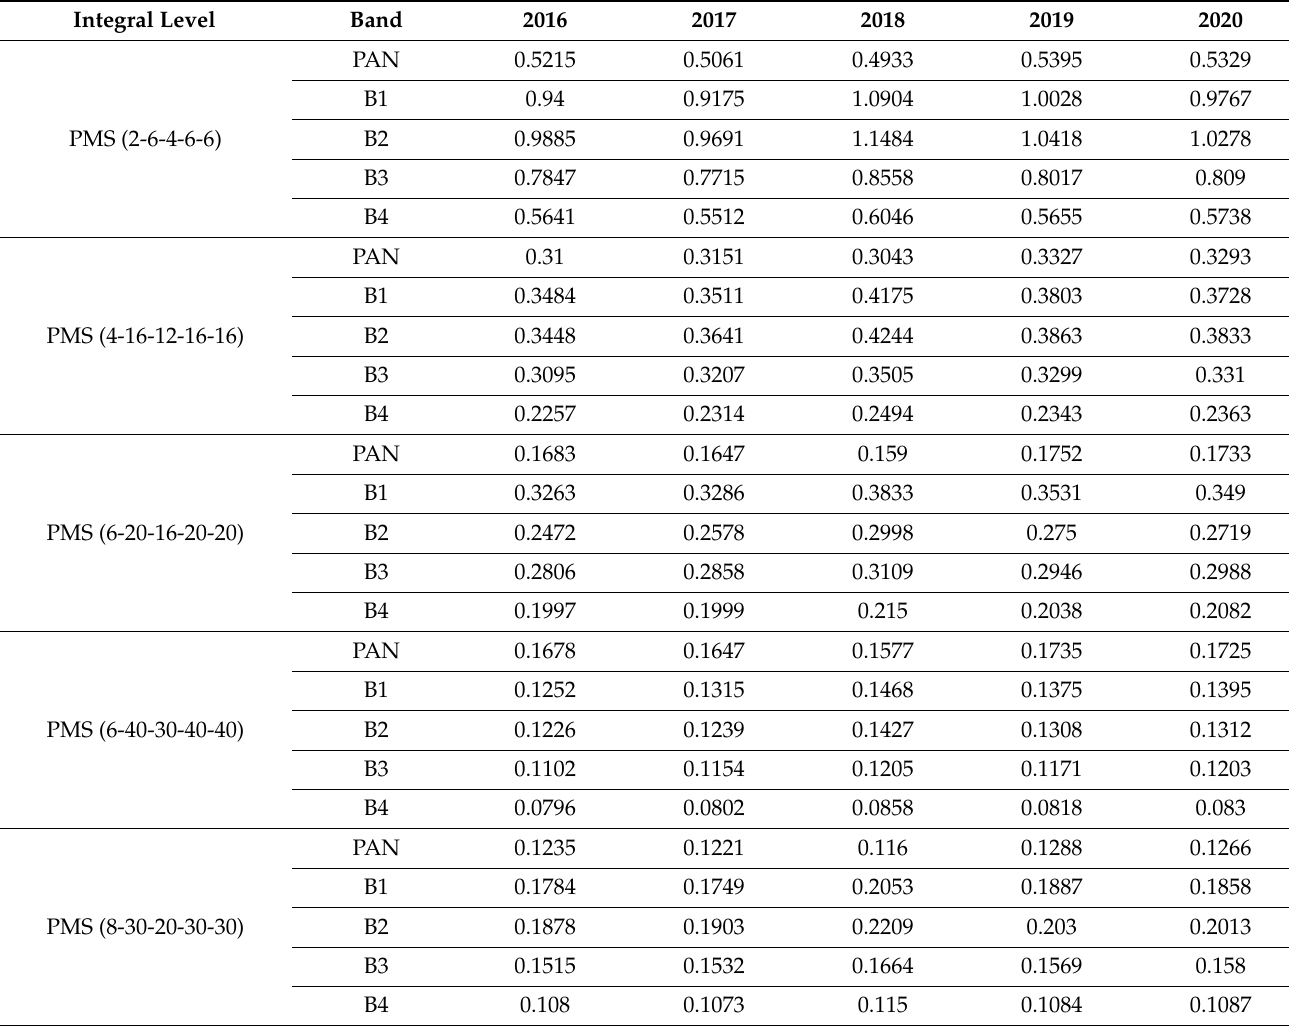
Table 3. The calibration coefficients of each band with different integral parameters from 2016 to